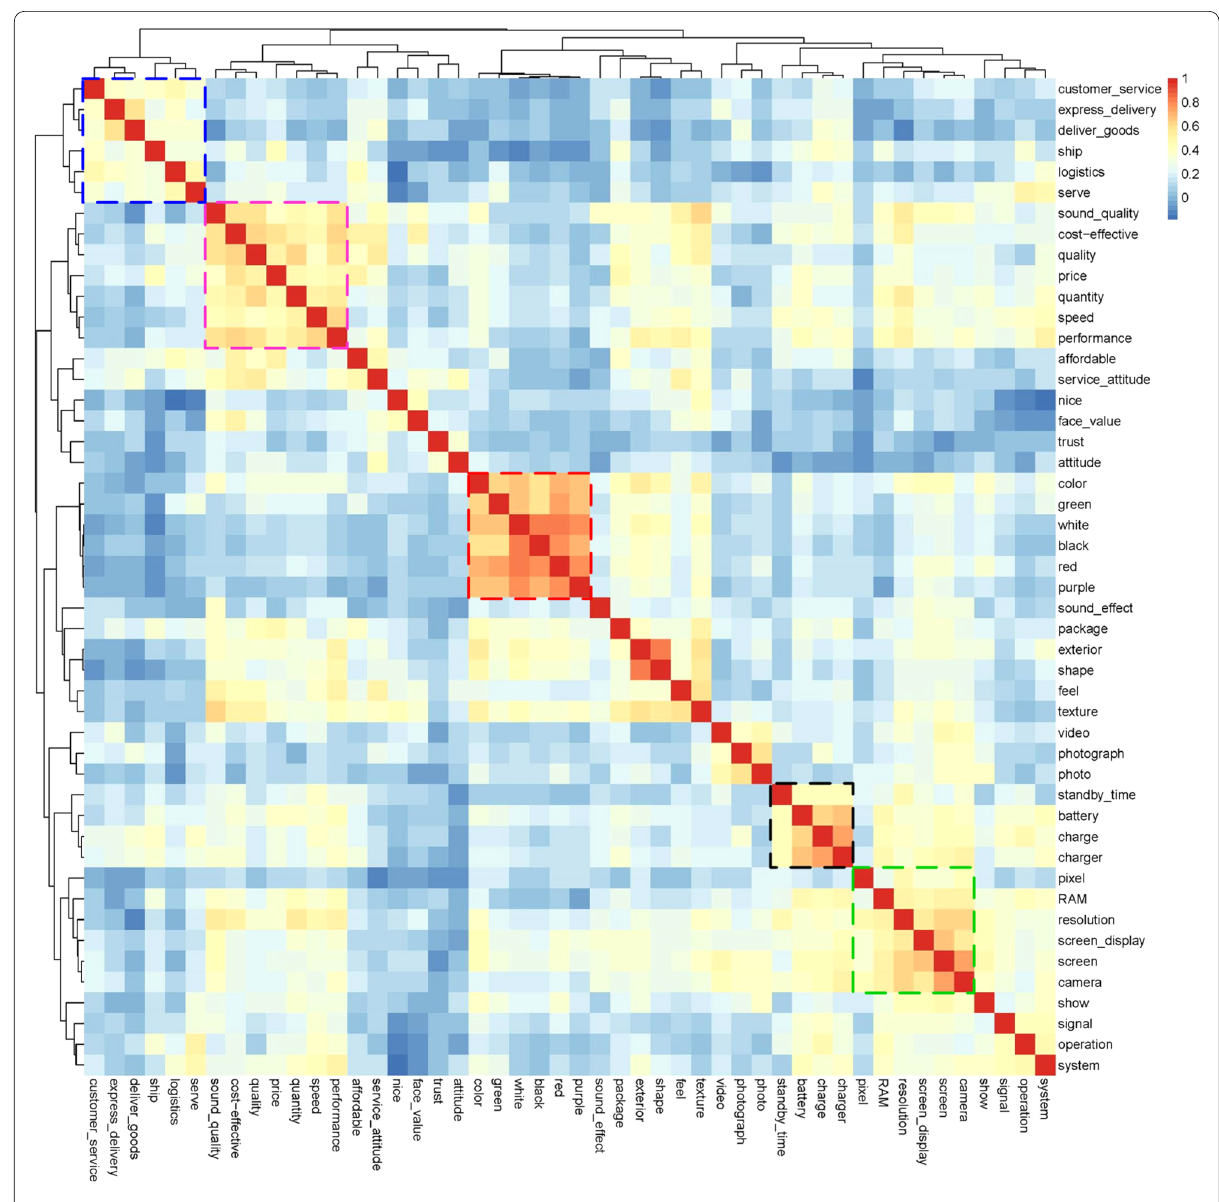
Figure 7 Heatmap and cluster map of the similarity matrix of product attributes